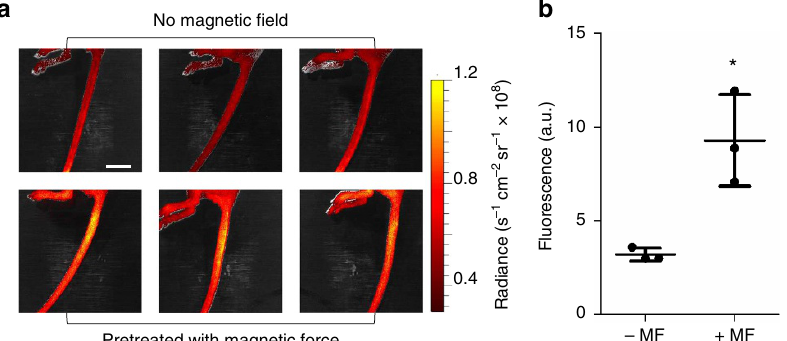
Figure 6 | Magnetic enhancement of vascular permeability in vivo . Athymic nude mice were injected with 33nm MNPs through one later tail vein and the one on the opposite site was exposed to the magnetic treatment. After that, the mice were injected with ICG (ex/em ¼ 710nm/810nm). ( a ) Distribution of ICG without and with the magnetic treatment. The mice subjected to the magnetic treatment showed enhanced ICG accumulation in the area adjacent to the magnet. Scale bar, 10mm. ( b ) Quantification of ICG accumulation based on fluorescence intensity (mean ± s.d.; n ¼ 3; * P o